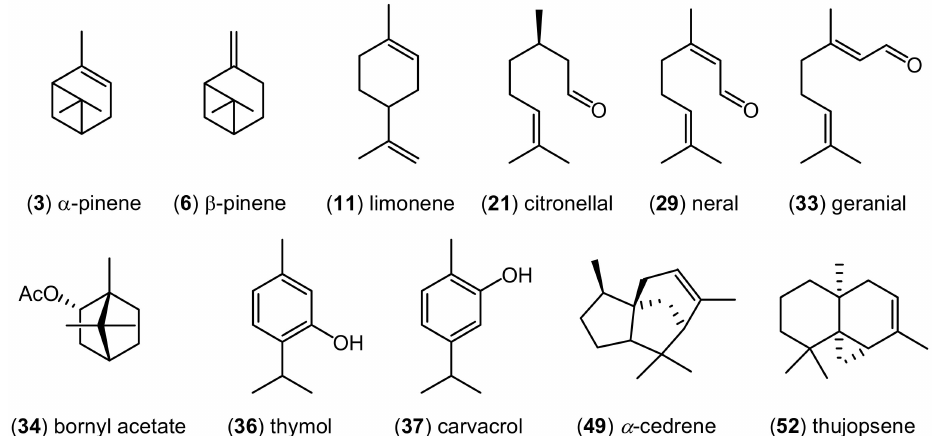
Figure 1. Structures of the major components present in the analyzed essential oils. Compound numbers identical to those in Table